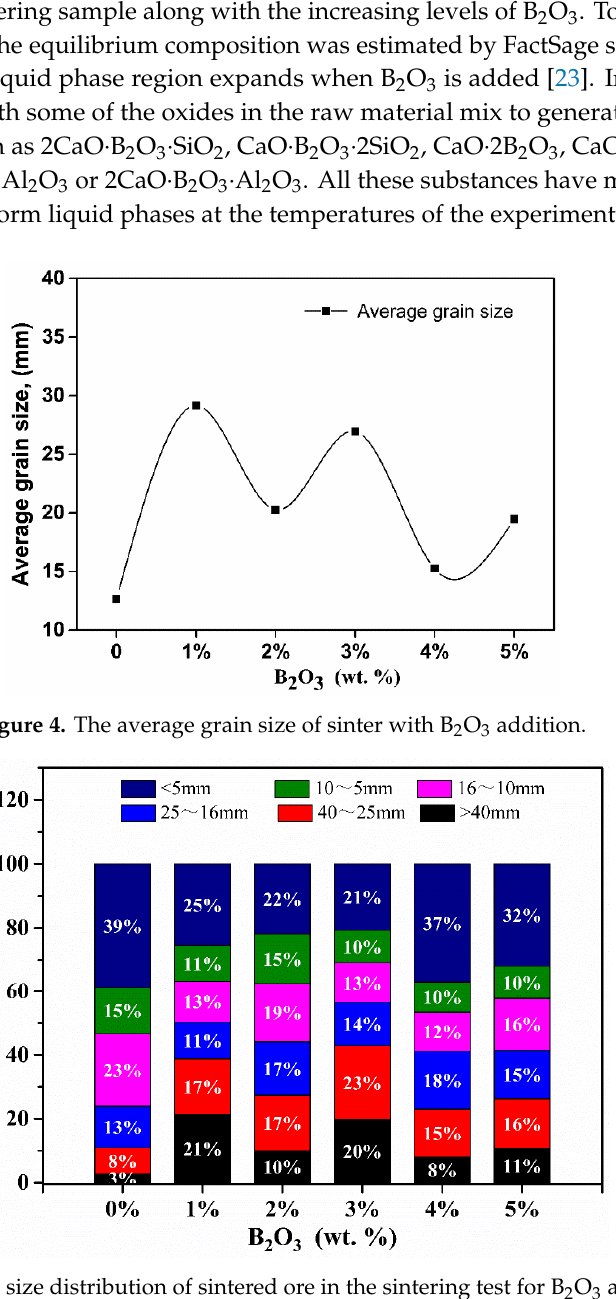
Figure 5. The size distribution of sintered ore in the sintering test for B 2 O 3 addition.